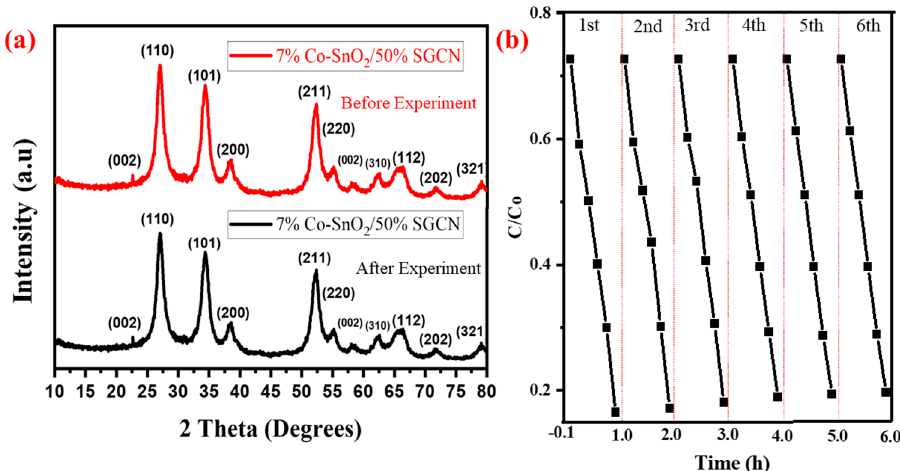
Figure 9. The stability and recyclability of the photocatalyst ( a ). X-ray diffraction patterns of the Co-SnO 2 /50% SGCN NCs before the experiment and after the 6th cycle ( b ). Table 3. Efficiency comparisons for photocatalysis of the Co-SnO 2 /SGCN NCs with some previ- ous works.